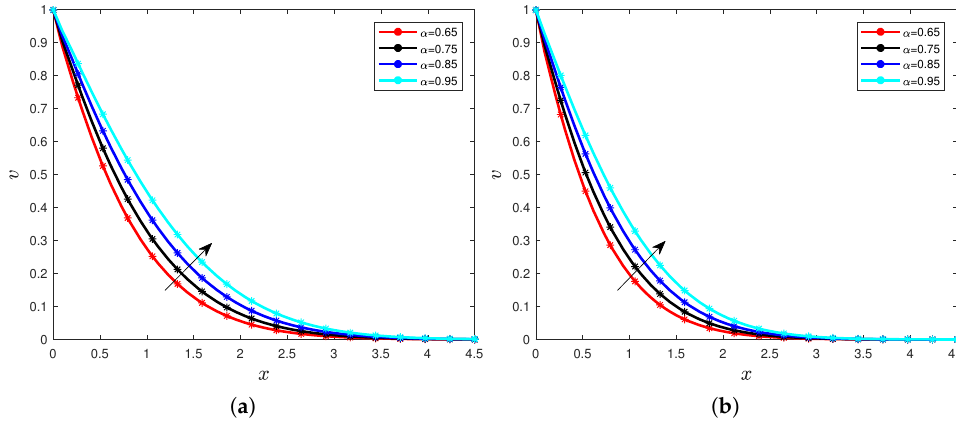
Figure 7. Temperature for different values of the fractional order with Pr = 10 ( a ) and Pr = 15 ( b ).